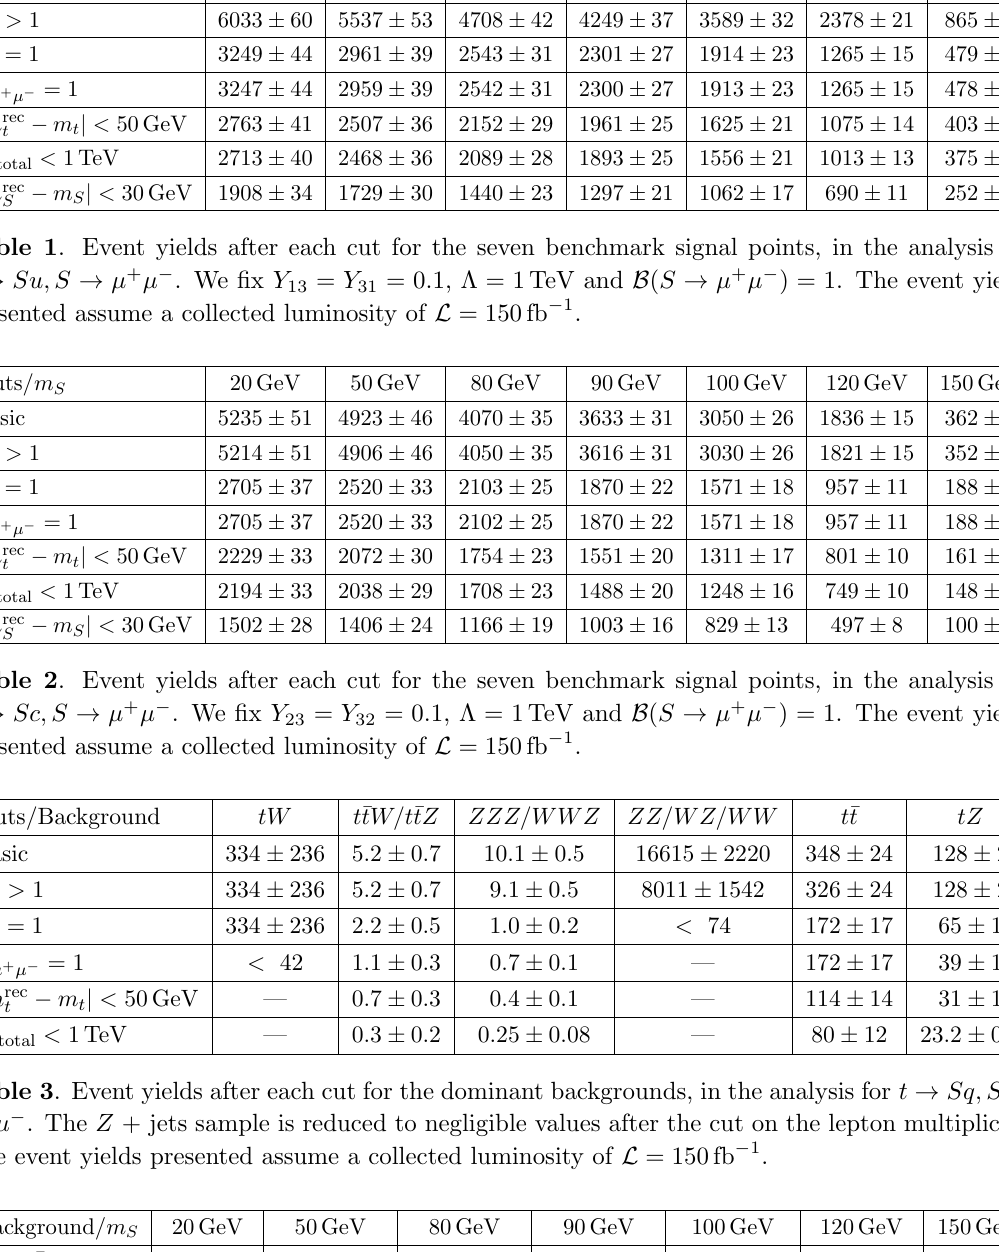
for the dominant backgrounds, in S